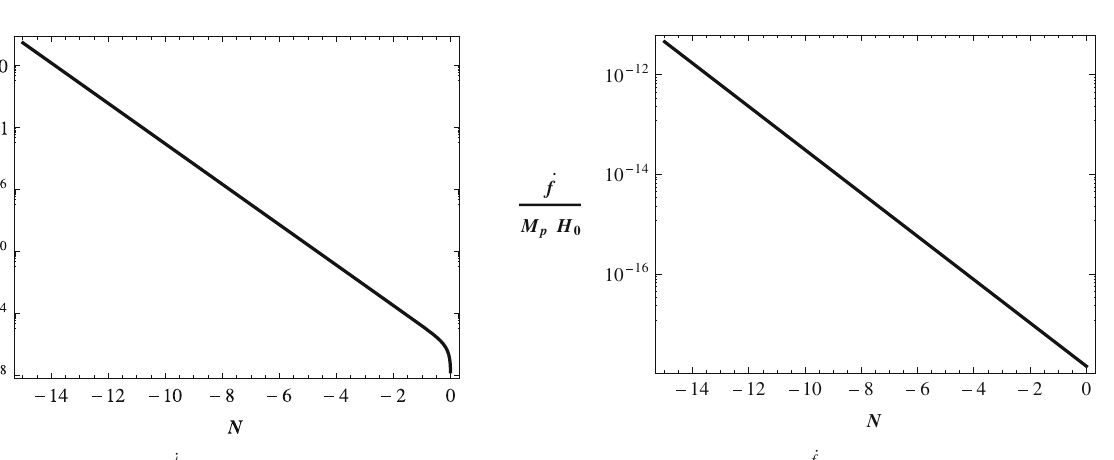
Fig. 3 Velocity of gauge field e-foldings